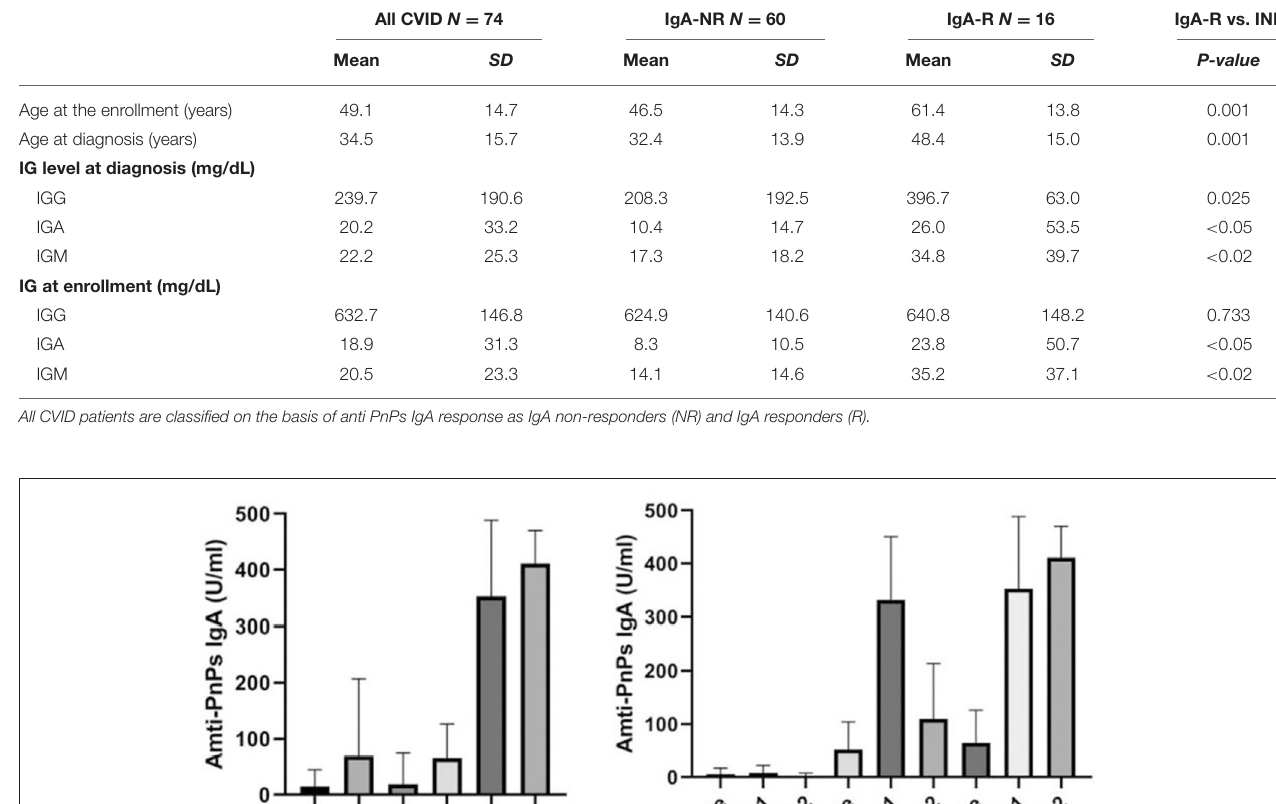
Frontiers in Immunology |